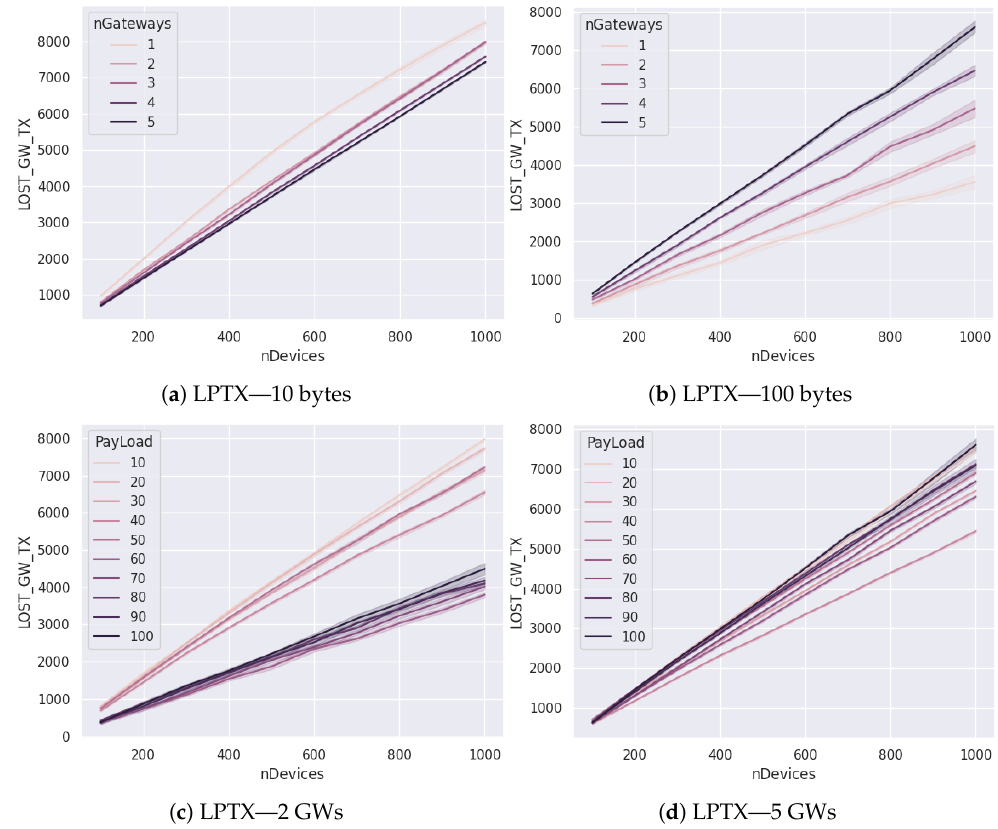
Figure 8. Number of lost packets at the gateway since it was in the transmitting phase while varying the number of gateways ( a , b ) and the payload length ( c , d ) with a frequency of 1 packet/min—confirmed